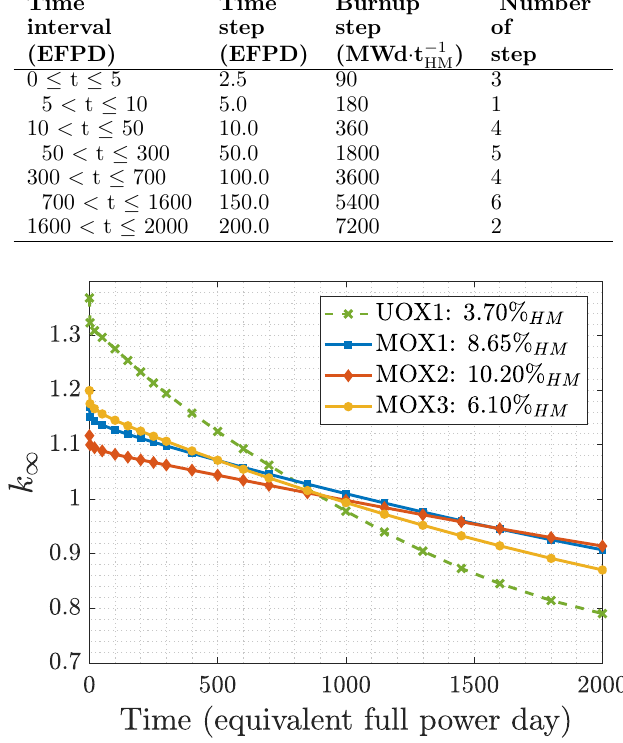
Fig. 3. Infinite multiplication factor evolution resulting from lattice calculations performed for UOx (green line) and MOx (other lines) fuel assemblies. Isotopic compositions for UOX1 as well as MOX1, MOX2 and MOX3 are presented in Table